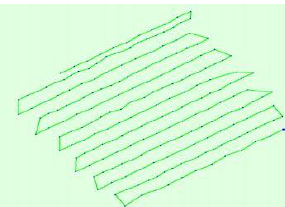
Figure 6. Image positions on the flight strips